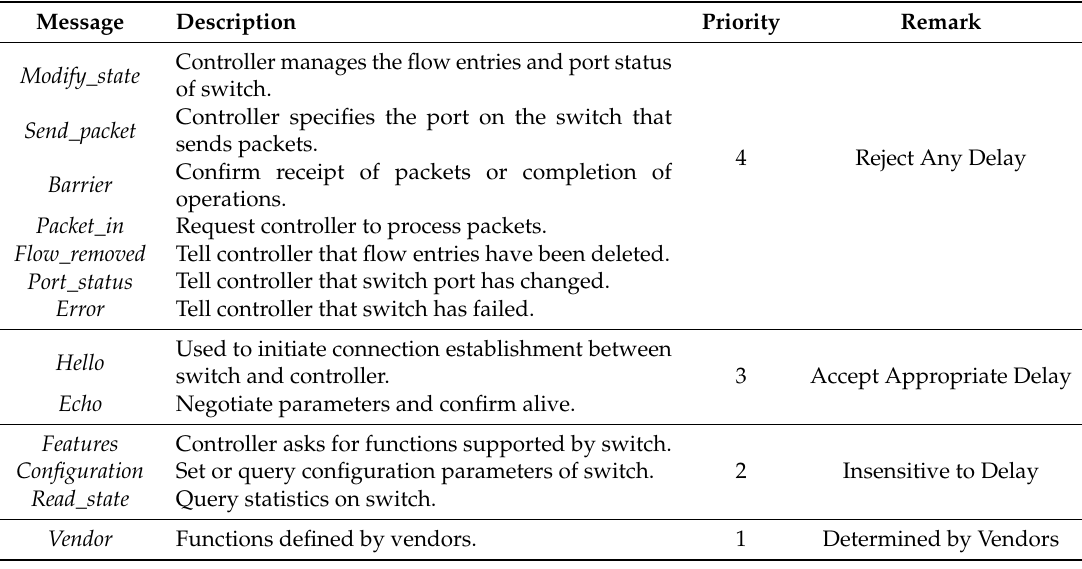
Table 1. The Classification of the Software Defined Networking (SDN) Control Plane